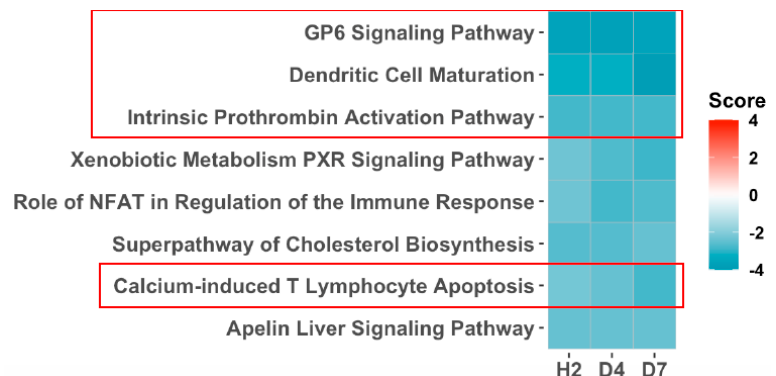
Figure 2. Pathway enrichment analysis of SDTGs ( p ≤ 0.05 and FC ≥ 2) after exposure to the lethal dose (20 Gy). Pathways that did not pass filtration criteria (z-scores ≥ Abs 2 and − log p ≥ 1.3) at a time point are dotted.